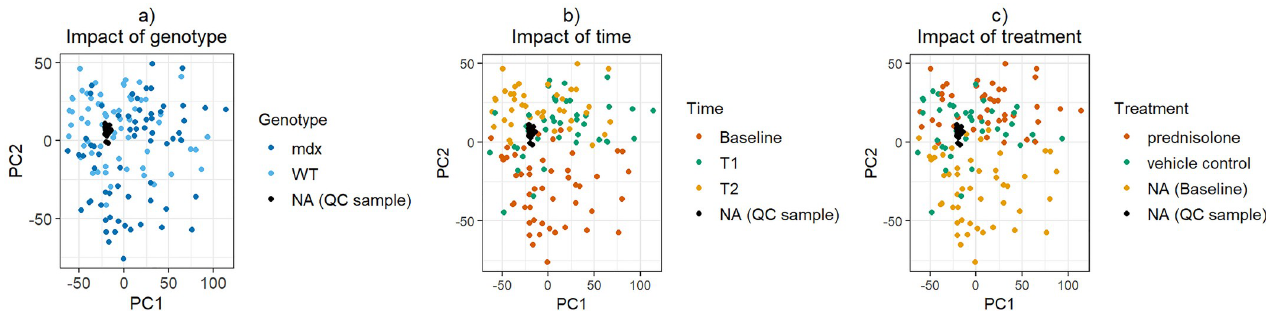
Fig 2. PCA plots of the internal standard normalized, quantile normalized, and log2-transformed intensity data. PC2 is plotted against PC1. Each circle corresponds to an individual sample. In panel a), samples are color-coded by genotype, in panel b), by time point, and in panel c), by treatment.